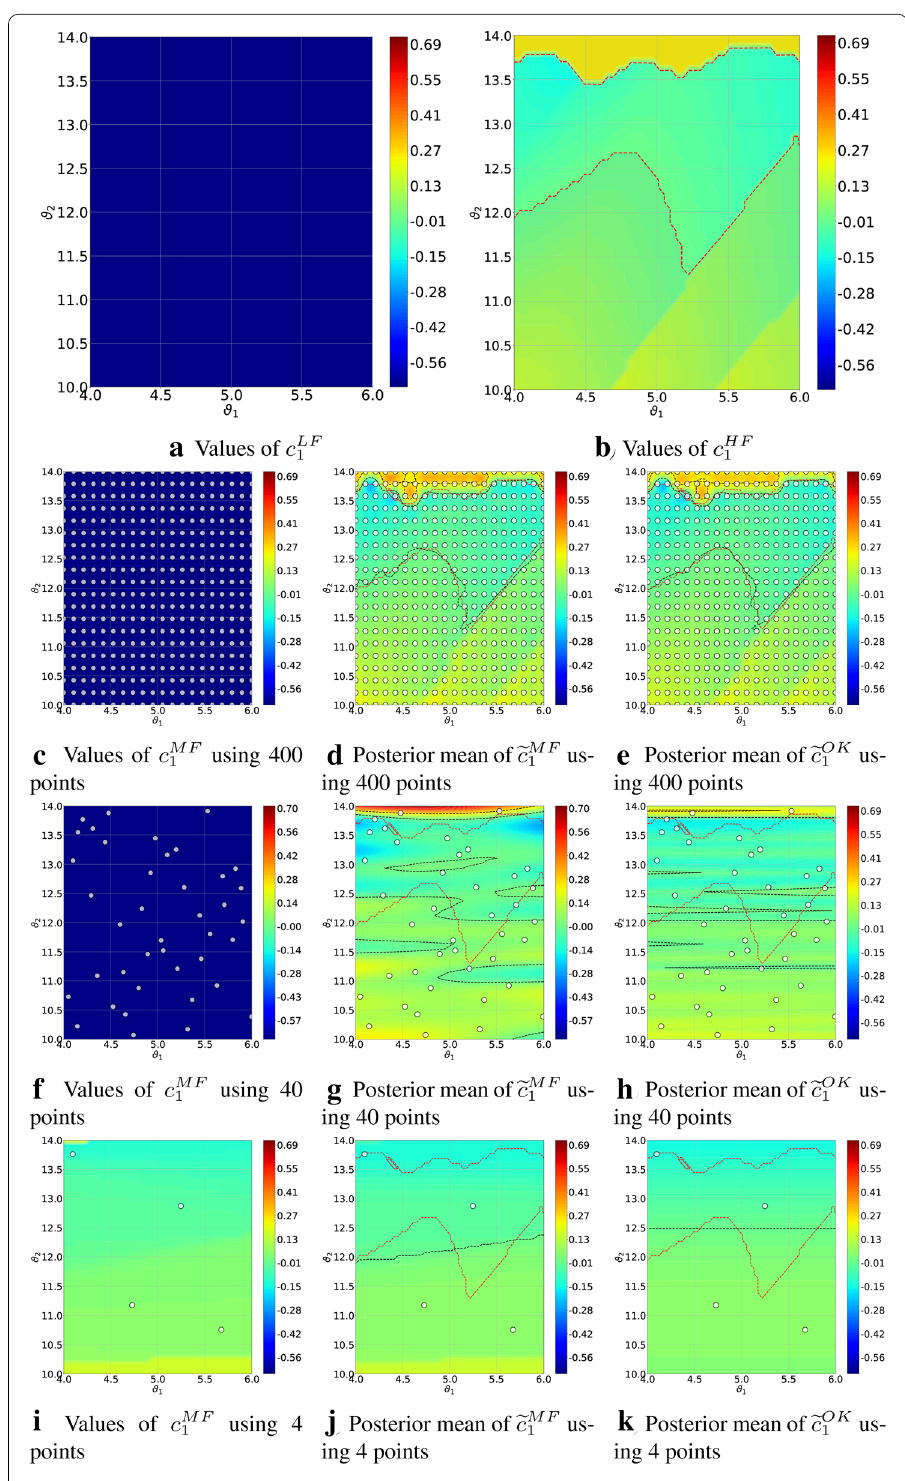
Fig. 4 The convergence of the MF trend, MF and OK models of the c 1 . In c – h , the left, the middle and the right columns show the values of c MF white